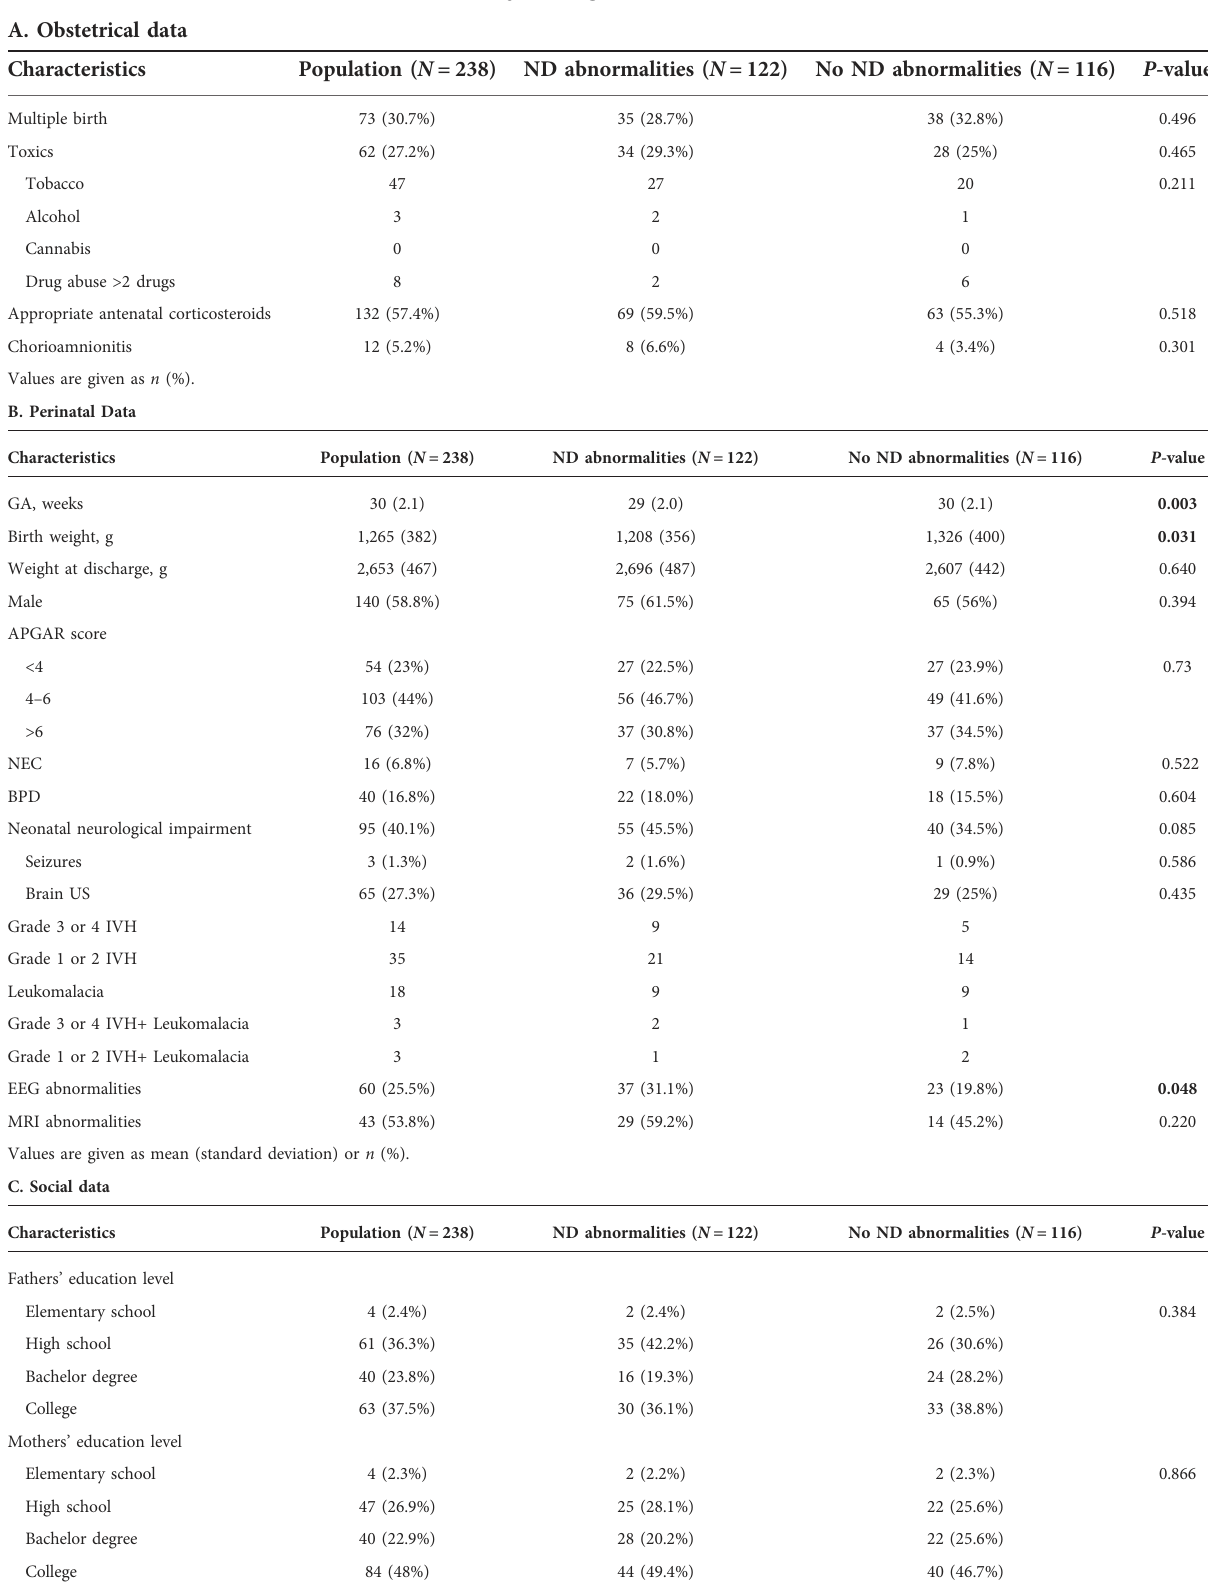
TABLE 2 Preterm infants involved in the rafael network at 7 years of